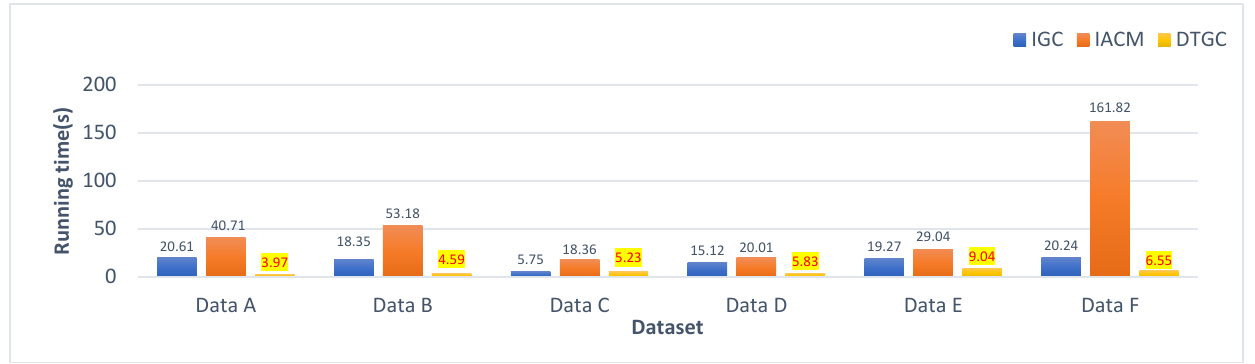
Figure 11. Runtimes of the various methods using dataset.